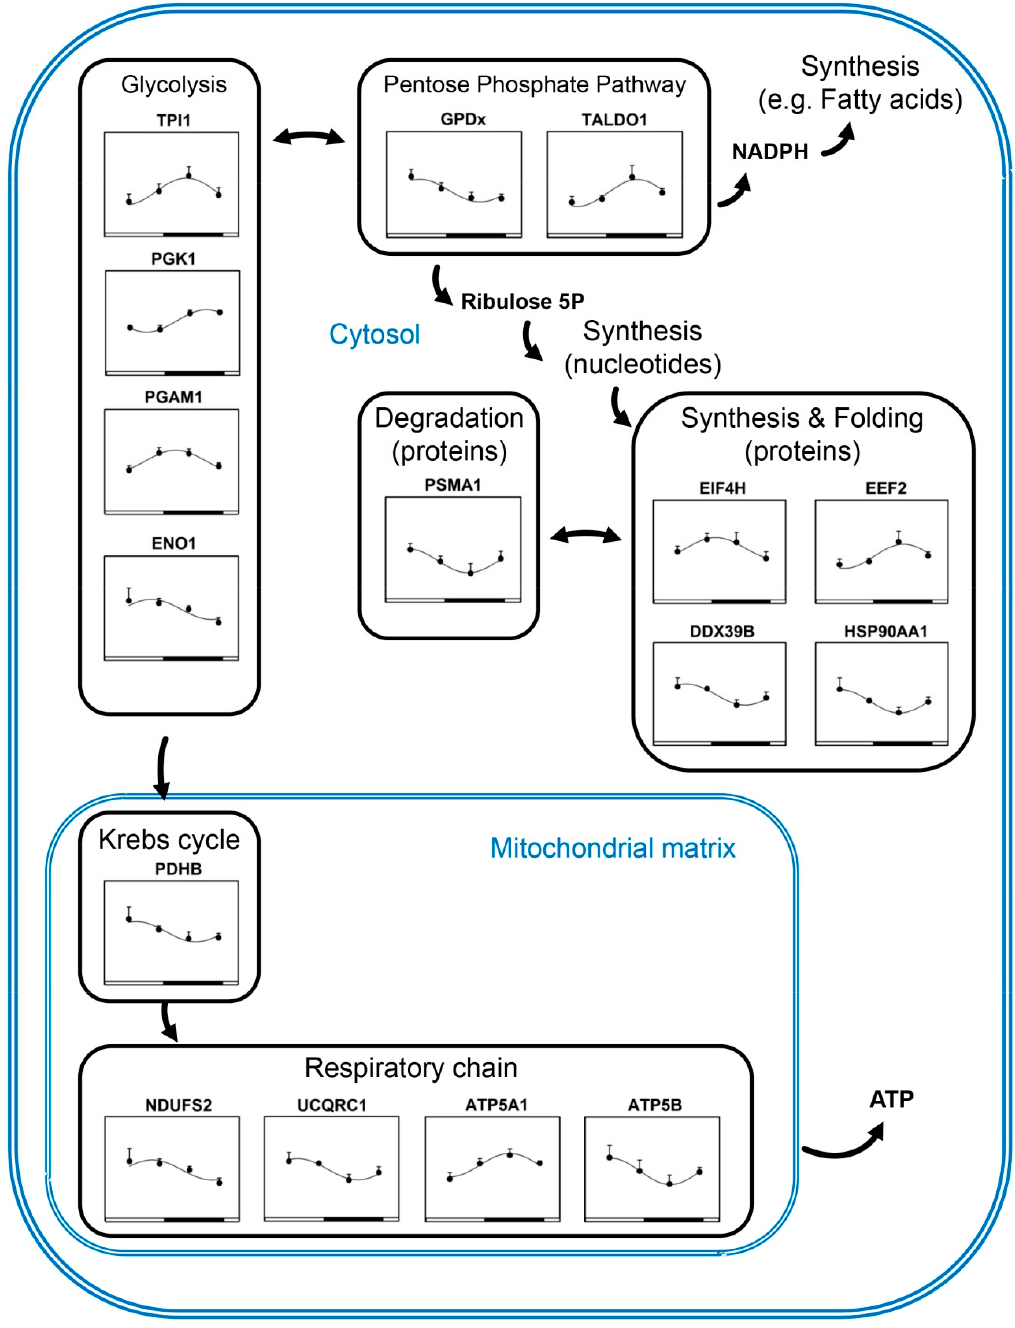
Figure 3. Visualisation of the daily expression of proteins on metabolic pathways in the cerebellum. Fitted curves represent significant cosinor regressions. See also Table 1 and Table S1. Data are shown as mean ± SEM.